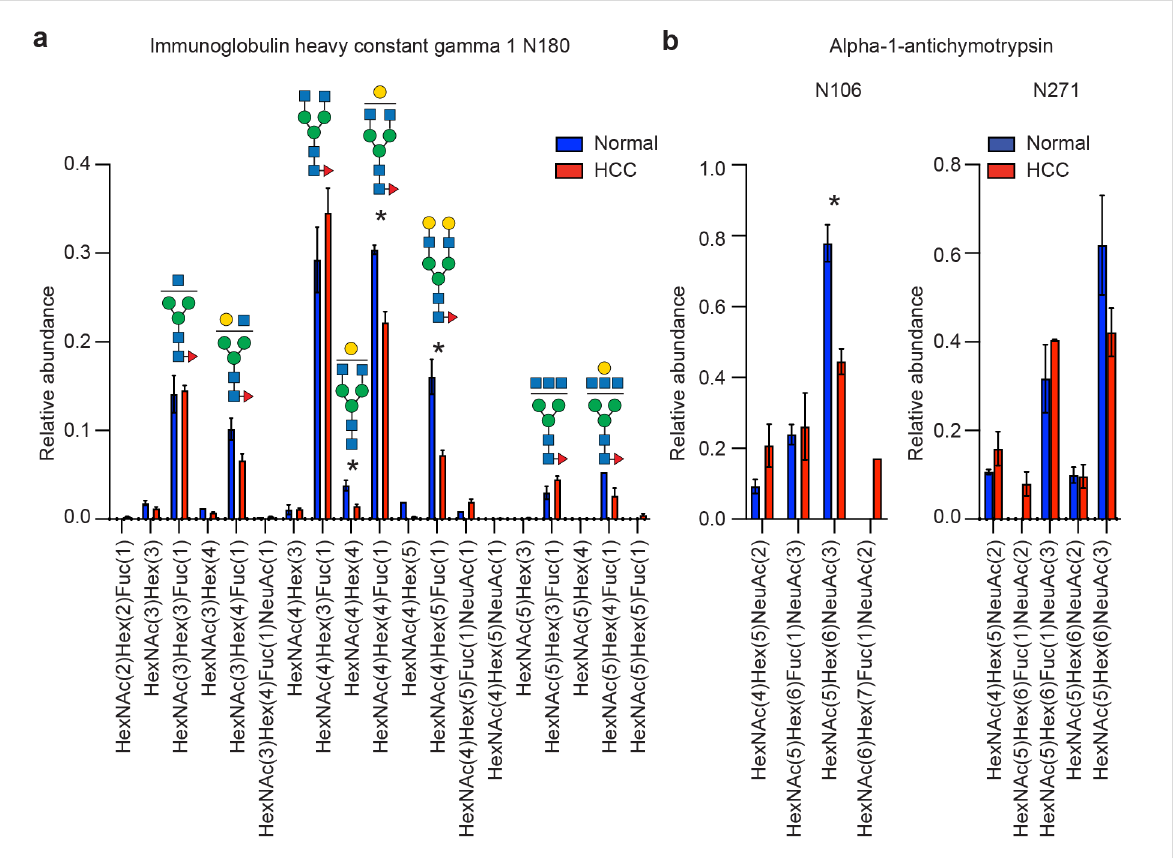
Figure 1: Evaluation of GlypNirO site-specific N -glycosylation profiling. Site-specific relative glycoform abundance in HCC and healthy controls at (a) immunoglobulin heavy constant gamma 1 (IgG1) N180, and (b) alpha-1-antichymotrypsin N106 and